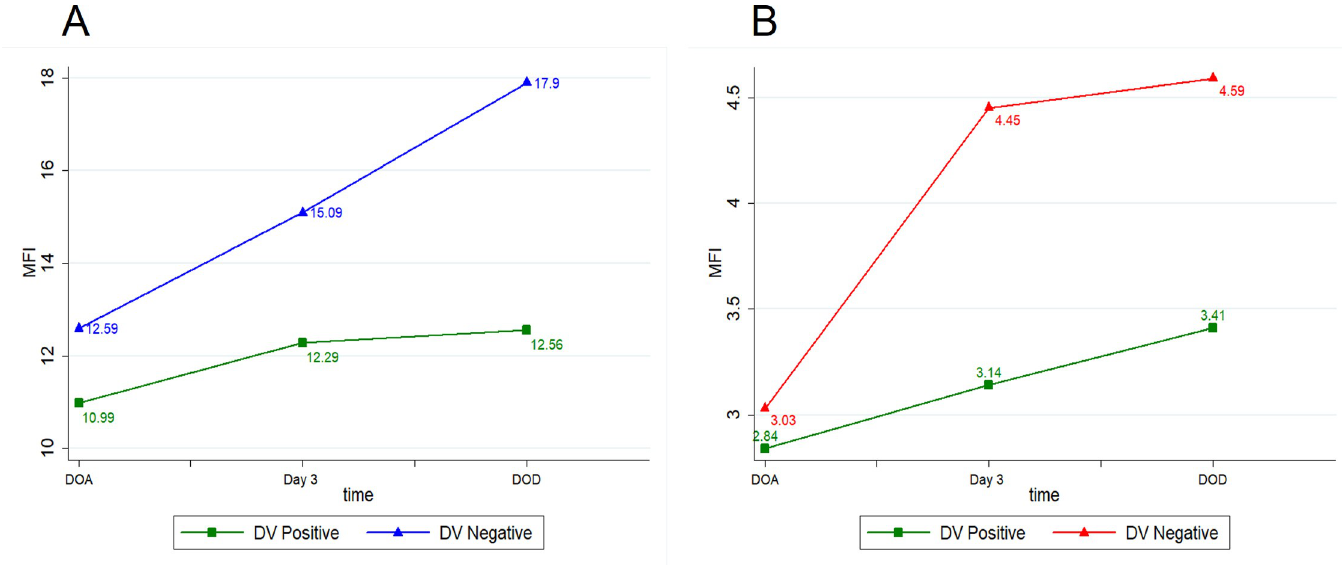
Fig 4. Line graph among different DV groups (A) DC-SIGN (CD209) (B) FC U R2A (CD32). (DOA- Day of Admission, DOD- Day of Discharge).